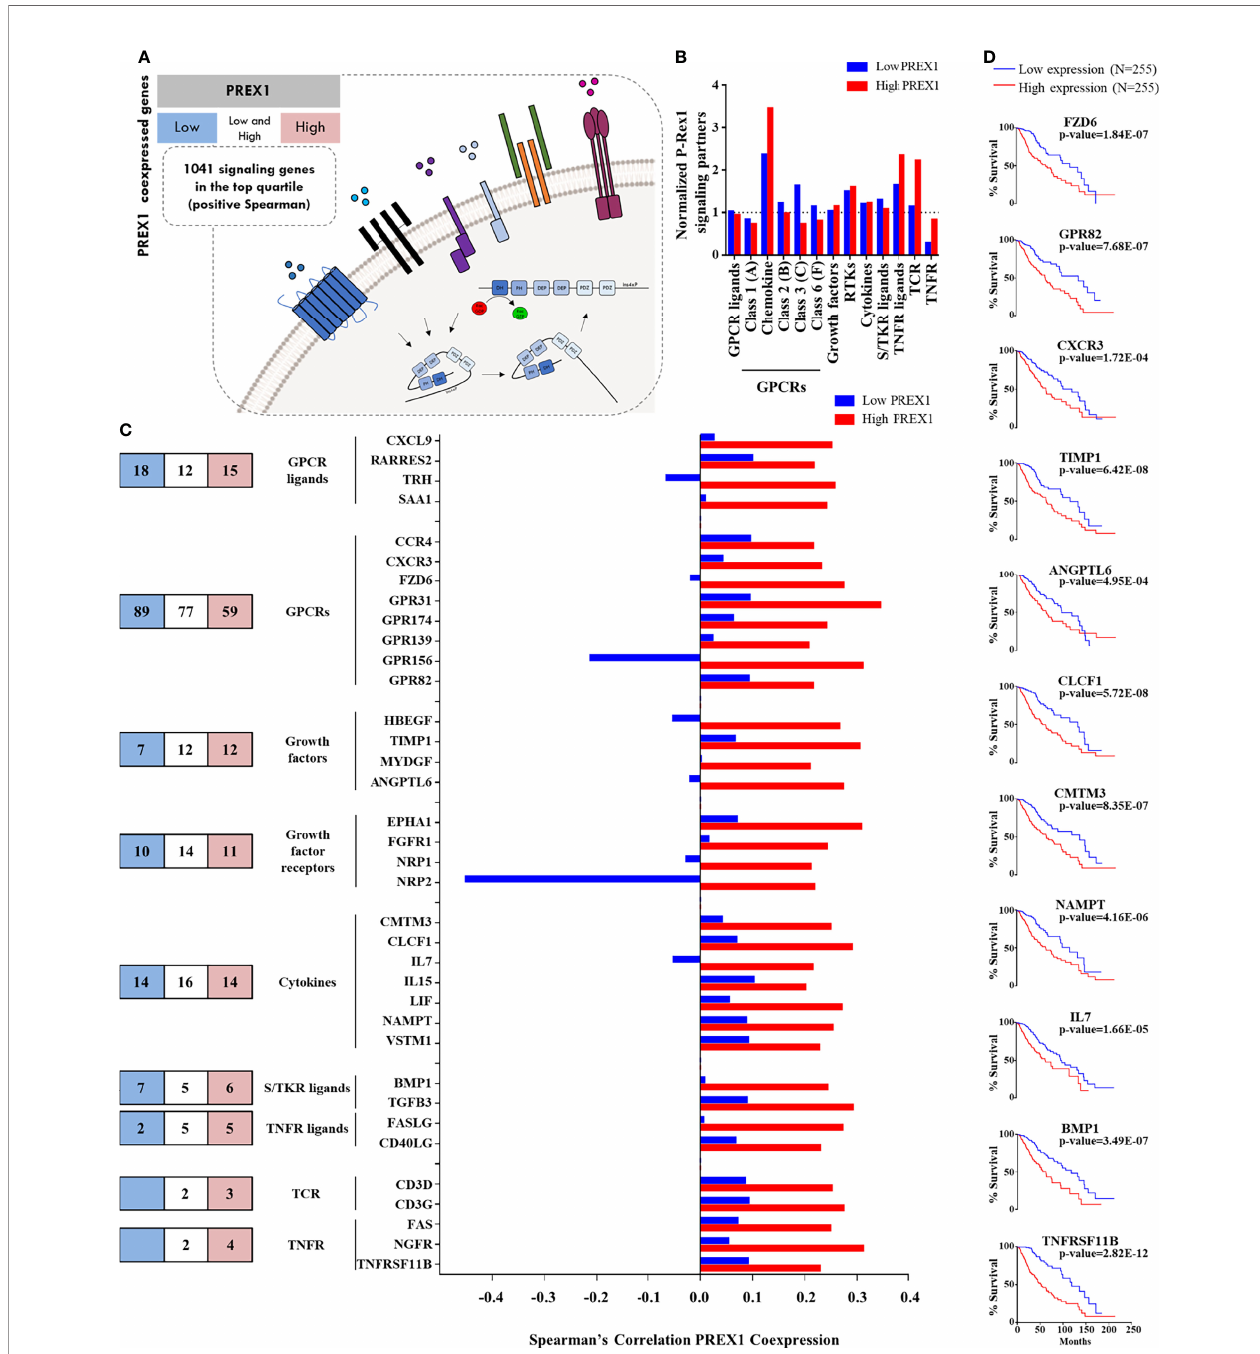
FIGURE 2 | Agonists and receptors highly coexpressed with PREX1 in LGG. (A) Model representing the strategy to identify PREX1 signaling partners in LGG tumors highly expressing this RacGEF. The LGG TCGA transcriptomic dataset was divided in low and high PREX1 expression groups. Potential P-Rex1 signaling partners were identi fi ed in the top quartile of coexpressed genes by merging the data with a list of all human signaling proteins tagged by their functional characteristics. The list included agonists and receptors (this fi gure), kinases and phosphatases ( Figure 3 ) and a diversity of other signaling proteins ( Figure 4 ). (B) Normalized coexpression of PREX1 with agonists and receptors within the fourth quartile of high and low expression groups. Number 1.0 indicates that the number of coexpressed signaling proteins is the same as one quarter of existing transcripts for the indicated group. (C) Number of agonists and receptors in the top quartile of genes coexpressed with PREX1 identi fi ed in the low (blue), high (red) or both (white) coexpression groups. The graph at the right compares the coexpression with PREX1 of agonists and receptors in the high and low expression subsets. Only those with higher Spearman ’ s correlation value with PREX1 in the high expression group are included. (D) Overall survival curves based on the expression of agonists and receptors highly coexpressed with PREX1 (50:50 percentiles). Statistical signi fi cance was analyzed by the Log-rank